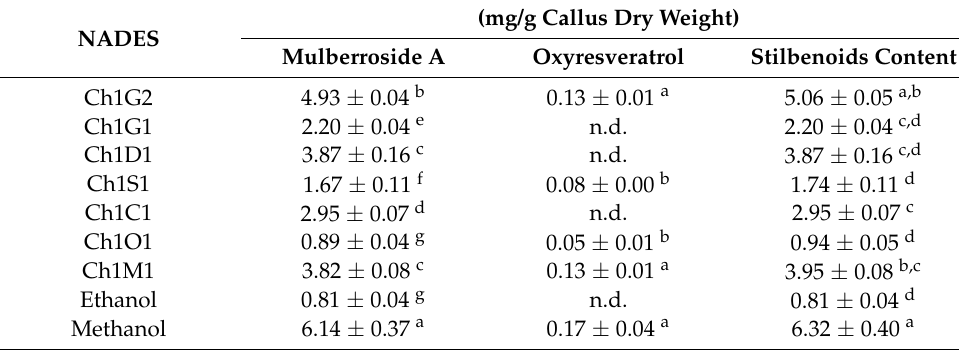
Table 2. Extraction yield of stilbenoids in NADES (mean ± SD, n =